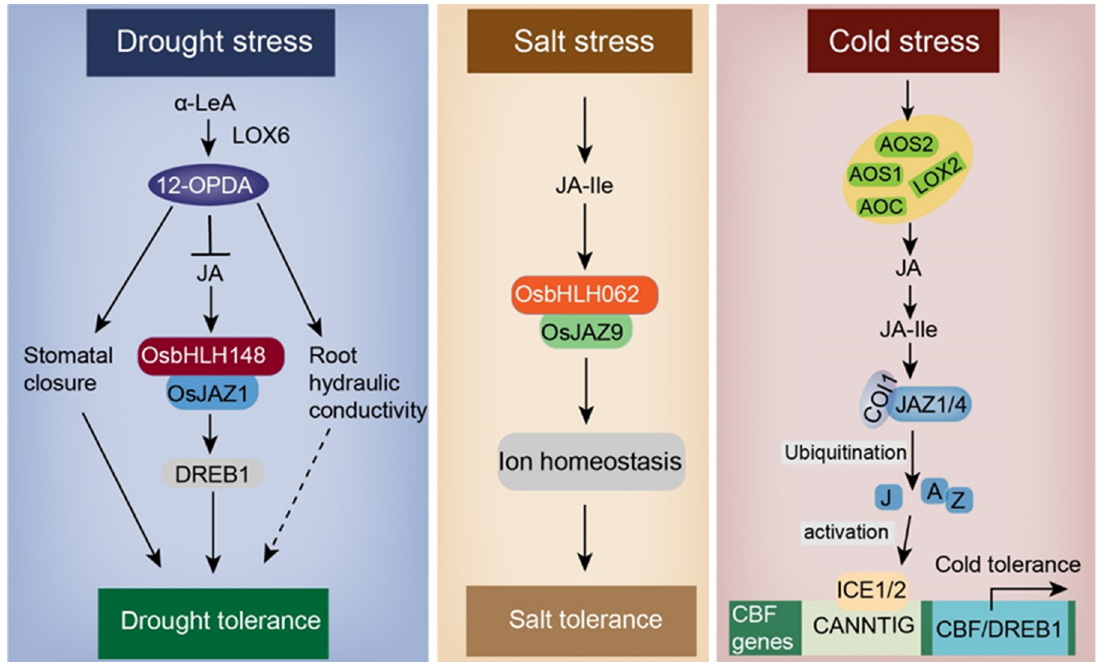
Figure 6. Jasmonic acid (JA)-mediated drought, salt, and cold stress responses in plants. Under drought, salt, and cold stresses, the JA signaling pathway can be activated. When Oryza sativa encounters drought, expression of OsDREB1 is induced. The interaction of OsbHLH148 with OsJAZ1, along with JA-mediated root hydraulic conductivity and stomatal closure, improves drought tolerance in rice. Induced by the stimulus of salt stress, OsbHLH062 interacts with OsJAZ9, resulting in ion homeostasis and improved salt tolerance. In A. thaliana , cold stress induces the expression of AOS1, AOS2, AOC, and LOX2, which cause JA-Ile epimerization from JA. Furthermore, JA-Ile facilitates the interaction of JAZ with the F-box protein COI1 through ubiquitination to regulate the expression of downstream genes, thereby achieving cold toler- ance. Abbreviations: 12-OPDA, 12-oxophytodienoic acid; JA, jasmonic acid; bHLH148, basic helix-loop-helix 148; JAZ, jasmonate zim domain protein; DREB, dehydration-responsive-element-binding; LOX6, 13-lipxoxygenase 6; JA-Ile, jasmonic acid isoleucine; AOS, allene oxide synthase; AOC, allene oxide cyclase; CBF, C repeat binding factor; ICE, inducer of CBF expression; COI1, coronatine insensitive 1. (Redrawn based on [101]). A growing number of studies on various plants indicate the involvement of JA syn- thesis genes in drought resistance. For example, ectopic overexpression of CMLOX10 from